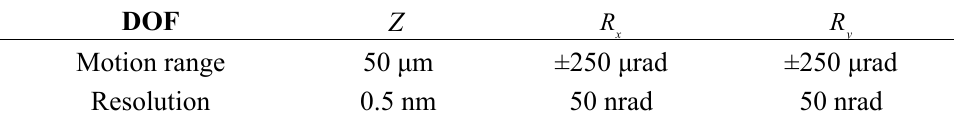
Table 1. Motion range and resolution in each degree-of-freedom (DOF)